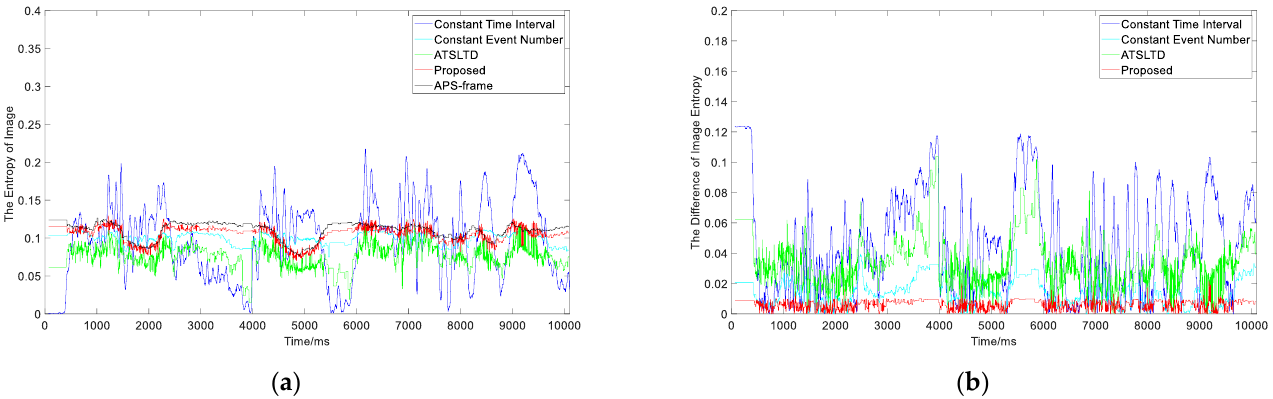
Figure 15. ( a ) The information entropy curve of virtual frame obtained by the four slicing methods and APS frame; ( b ) the difference curve between the information entropy of virtual frame obtained by the four methods and APS frame.